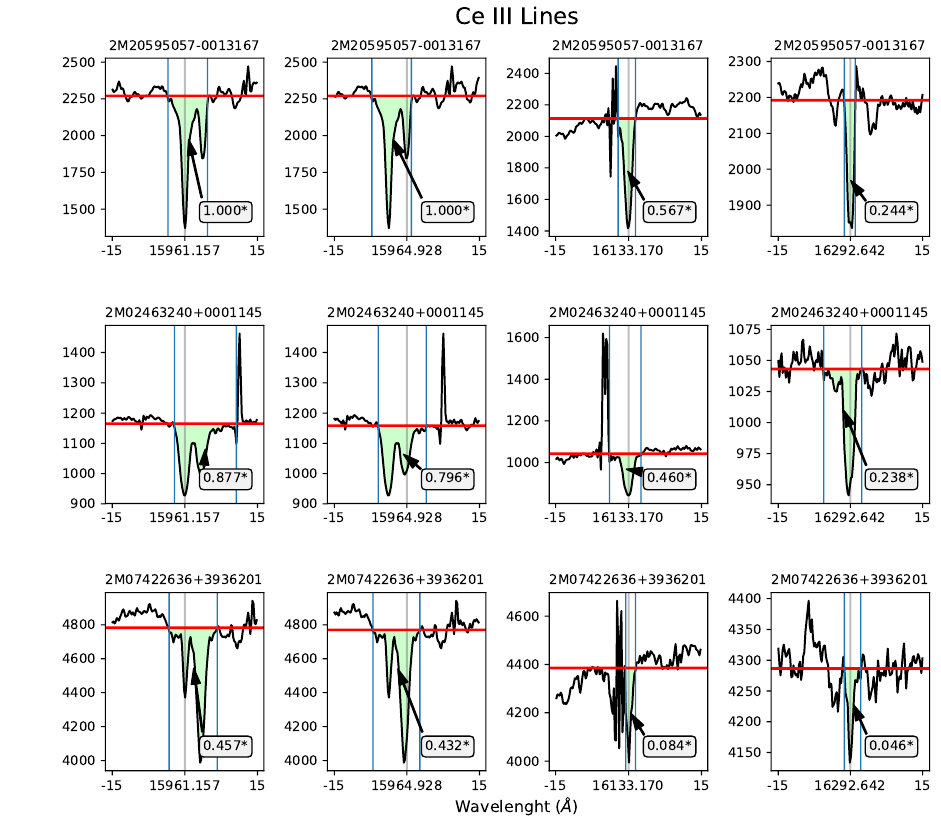
Figure 2. Ce III Lines. Each row shows a single target with cerium